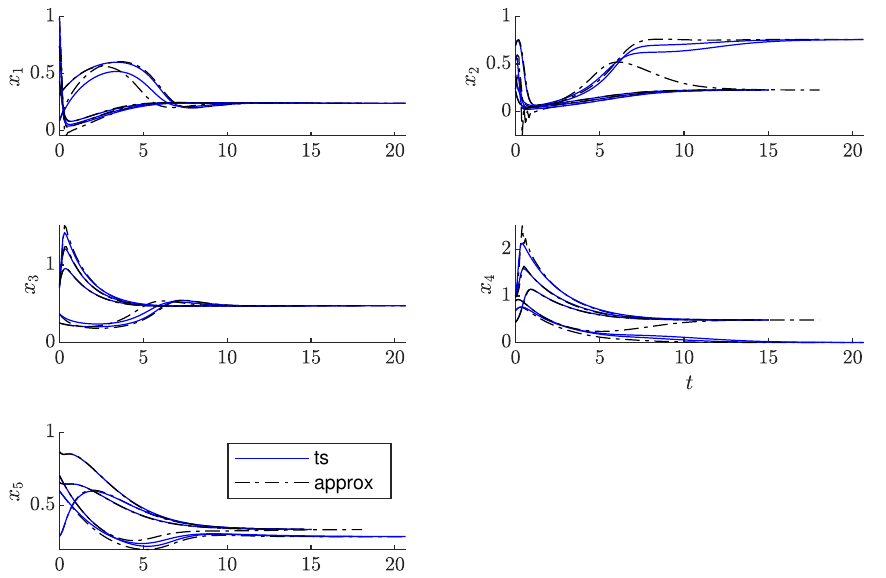
Figure 7. Comparison between the testing and approximation trajectories of the biochemical reac- tion